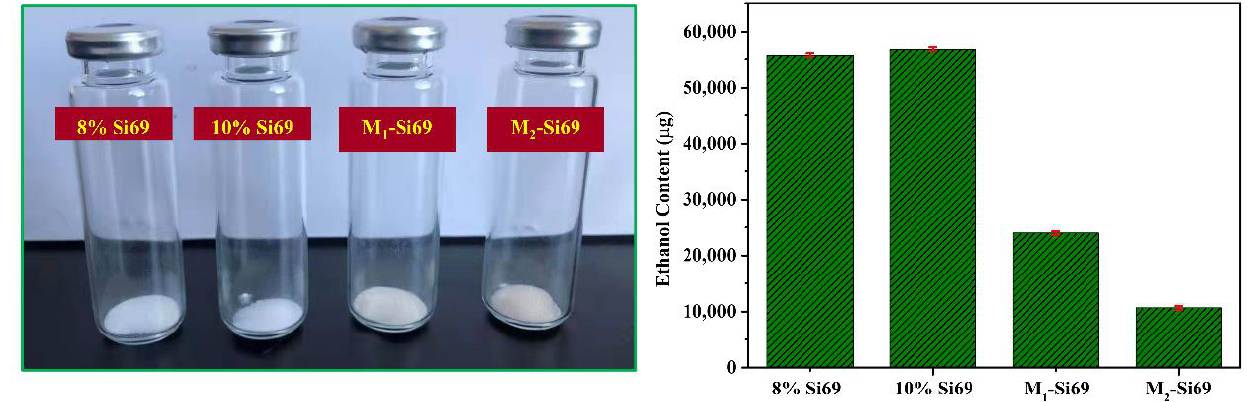
Figure 16. Characterization of the VOC content of coupling agent-modified silica.